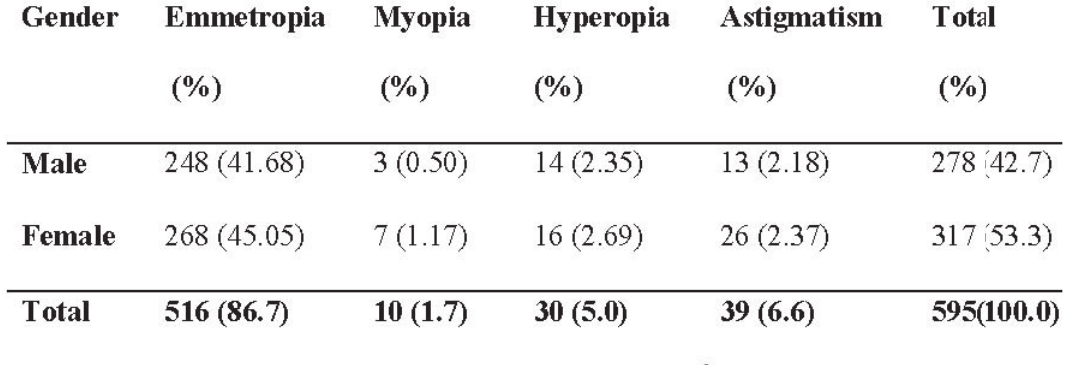
Myopia ranged between – 0.50 D to – 2.25 D,